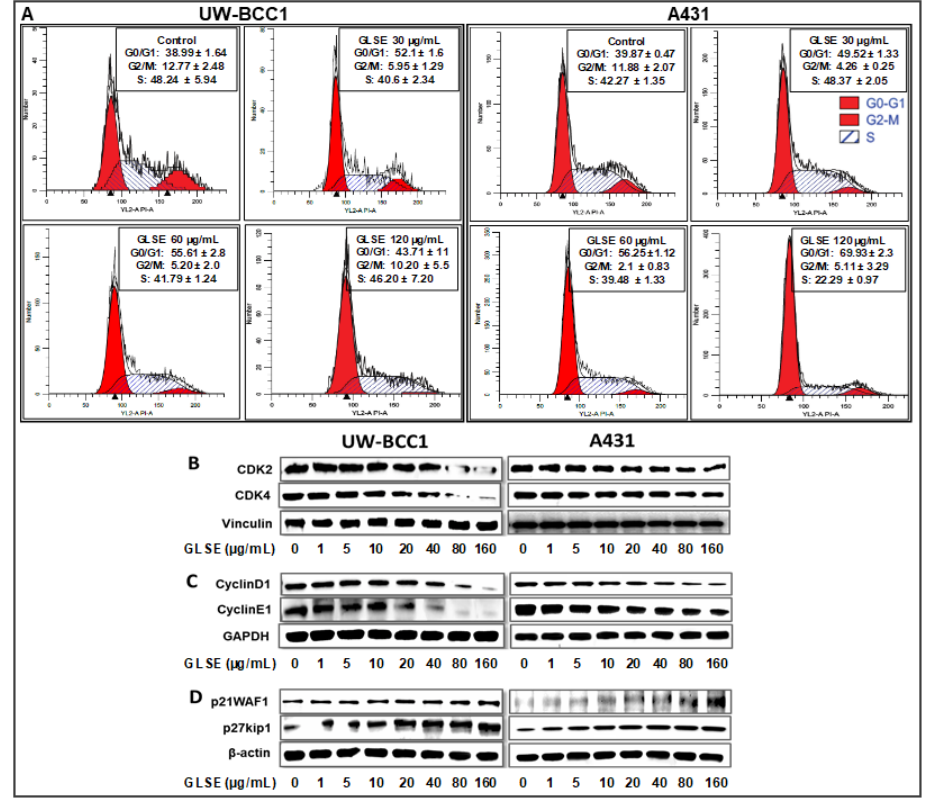
Figure 2. GLSE induces G 0 /G1 phase cell cycle arrest of non-melanoma skin cancer cells.